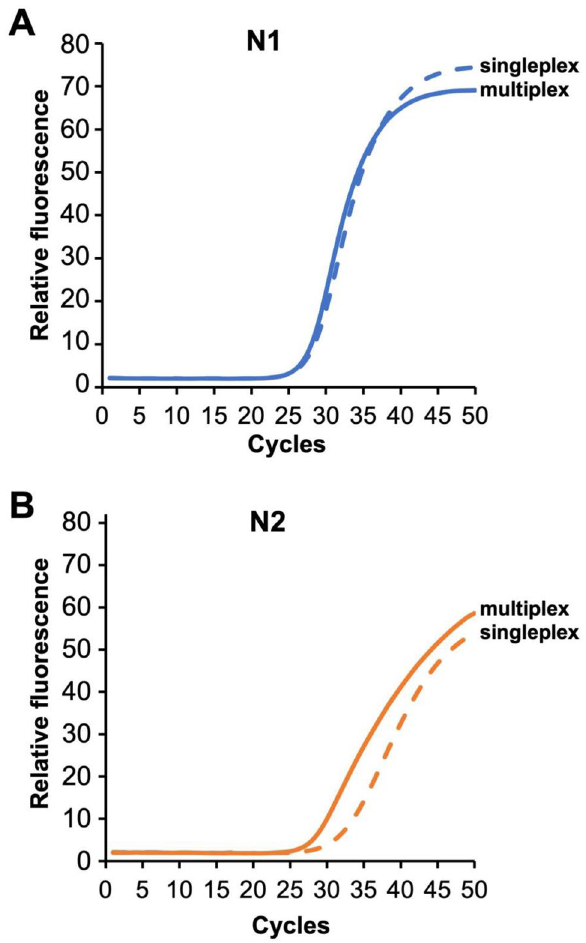
Figure 5. Comparison of singleplex and multiplex qRT-PCR with 5 µL of an unextracted positive patient sample added to the reaction. Each curve is the average of three experiments (N =